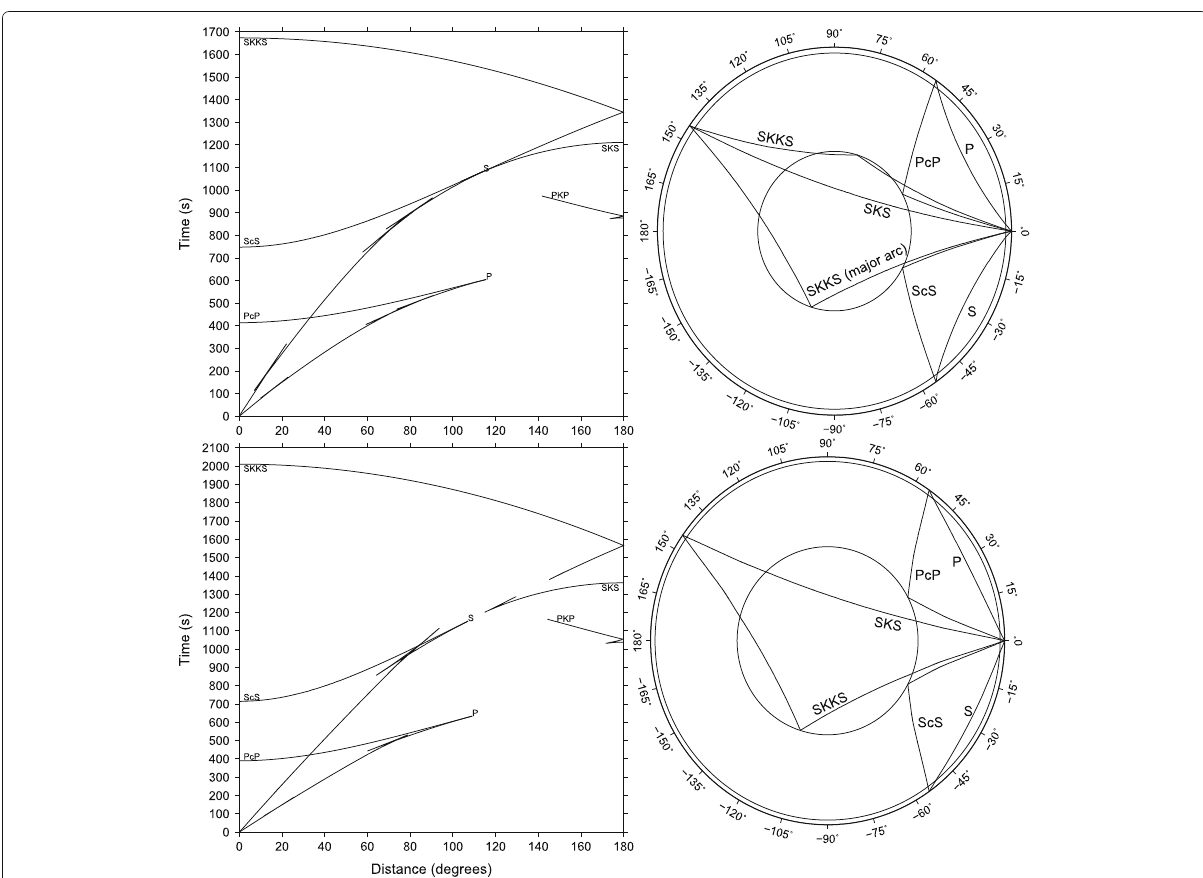
Fig. 8 Travel time curves (left) and ray paths (right) for two different Mars seismic models. (Top panels) Sohl and Spohn (1997) model A (SS97a); (bottom panels) Rivoldini et al. (2011) model based on the Dreibus and Wänke (1985) compositional model (R11DW). The diagram shows how the combination of core sizes and wavespeeds at the top of the outer core relative to V S at the base of the mantle affect the gross form of the seismic wave arrivals. The right panels show rays emanating from a seismic source at 0° to stations at 55 and 145°. R11DW features a core shadow to SKS and SKKS due to its lower core wavespeeds, one effect of which is that minor arc SKKS disappears at 130°. The core size affects the travel time of the core reflected arrivals PcP and ScS